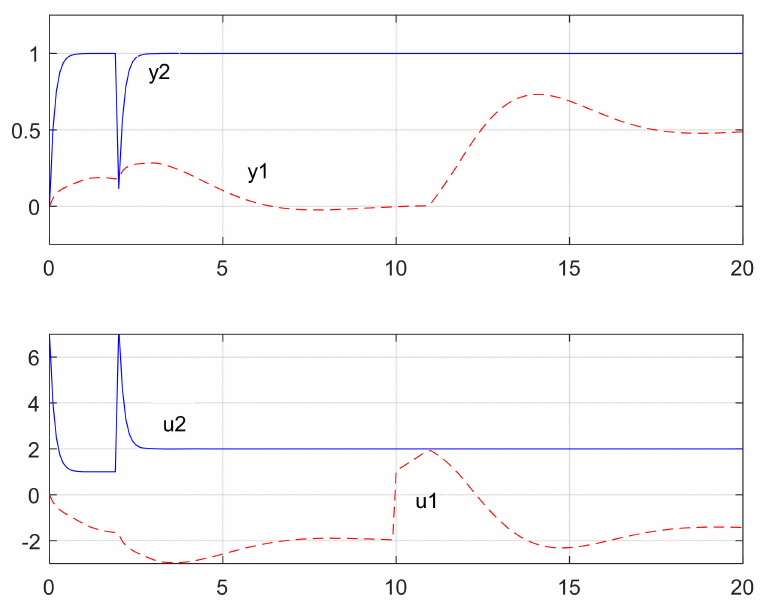
Figure 5. Reference tracking and disturbance regulation without de-coupling. Upper plot shows the system outputs y 1 and y 2 as functions of time. Lower plot shows the system inputs u 1 and u 2 as functions of time. The references in Figure 1 are r 1 = 0.5 σ ( t − 10 ) and r 2 = 1. The output disturbances in Figure 1 are d 1 = 0 and d 2 = − σ ( t − 2 ) , where σ ( t ) is the unit step function (or rather distribution) at time t = 0.